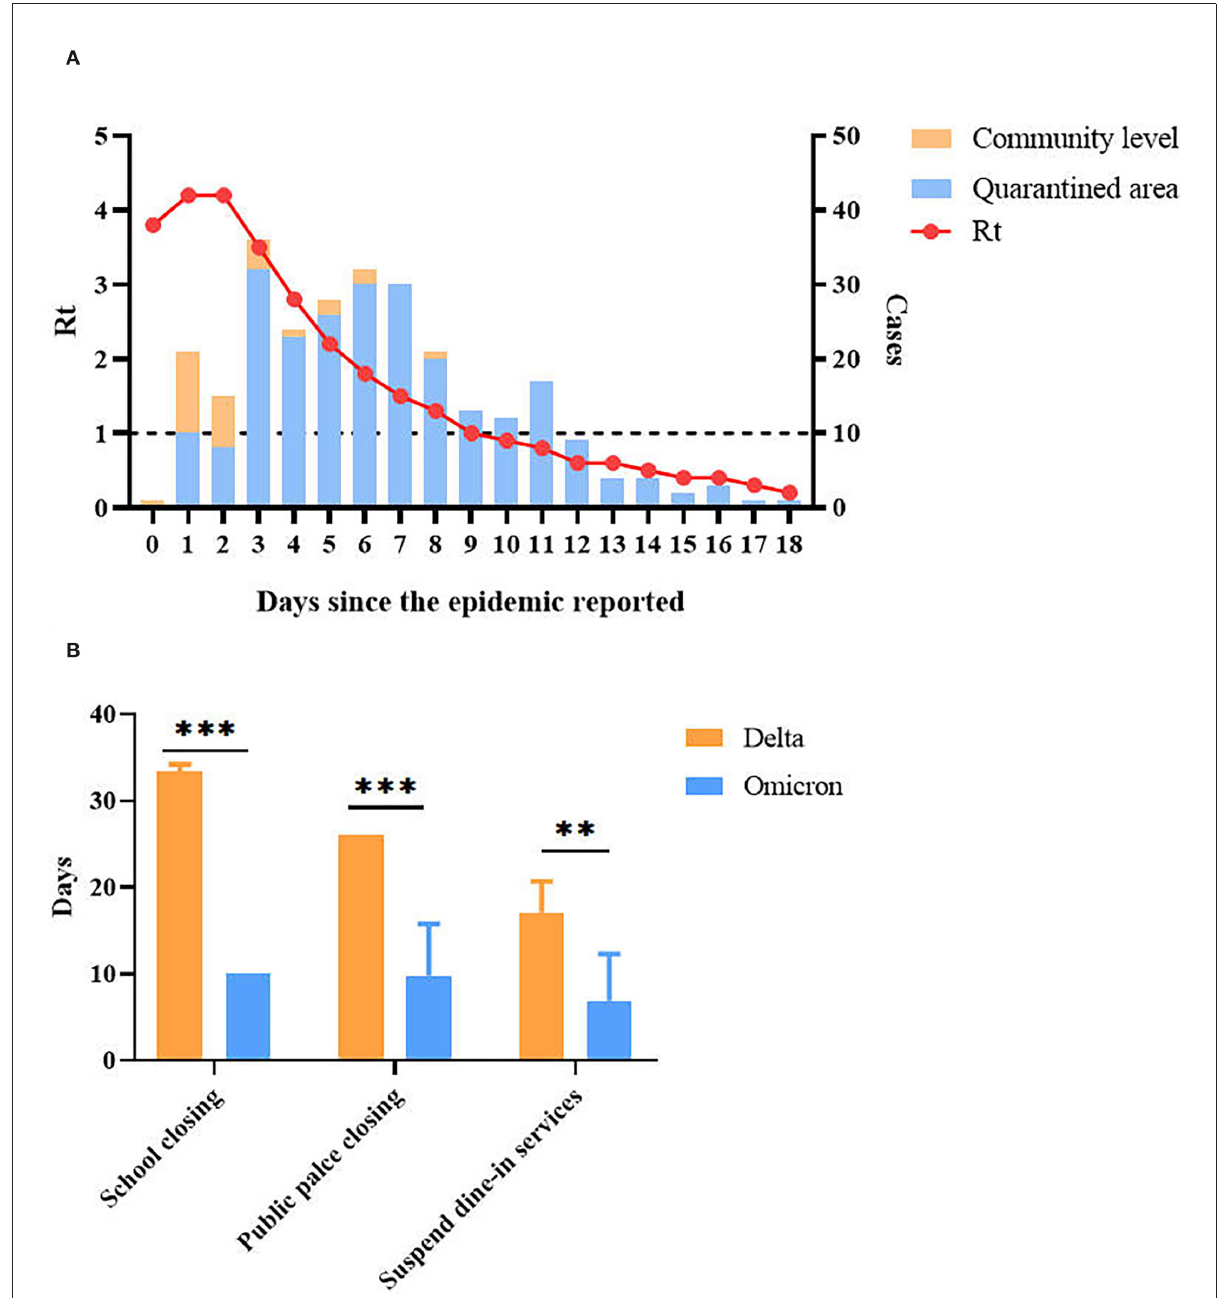
FIGURE7 Effectiveness of epidemic control (Omicron vs. Delta). (A) Rt throughout the epidemic. The epidemic started date is 8 April 2022. (B) The duration of non-pharmaceutical interventions (NPIs) implemented by the government. The ** and *** symbols indicate the P values < 0.01 and < 0.001 with the difference between groups are significant